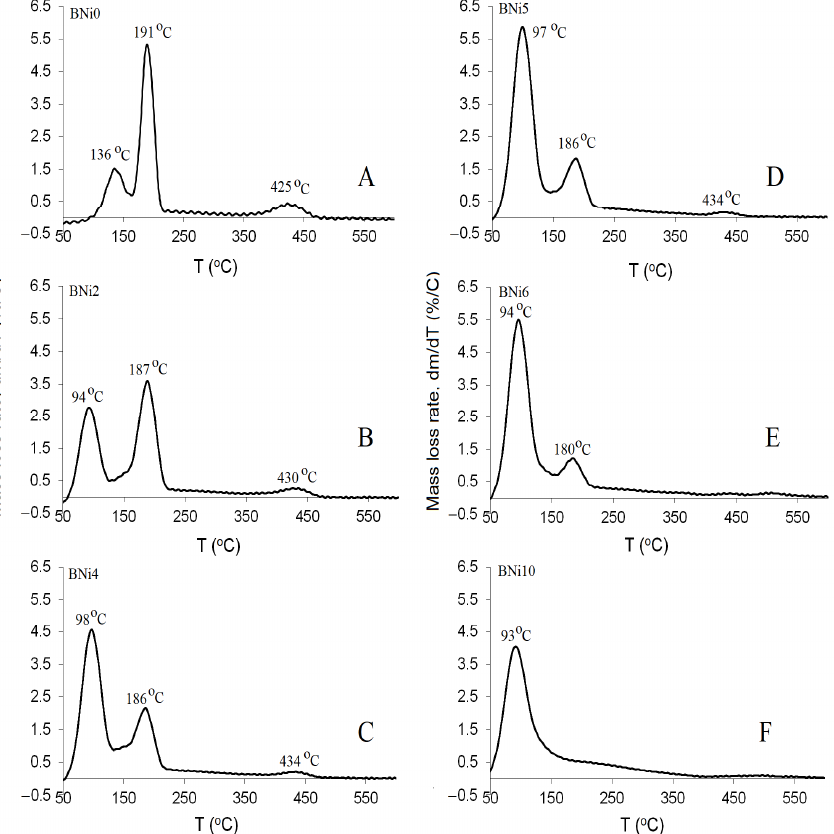
Figure 8. Differential TGA of diverse Ca x Ni 1-x HPO 4 ·nH 2 O compounds: ( A ) BNi0; ( B ) BNi2; ( C ) BNi4; ( D ) BNi5; ( E ) BNi6, and ( F ) BNi10.